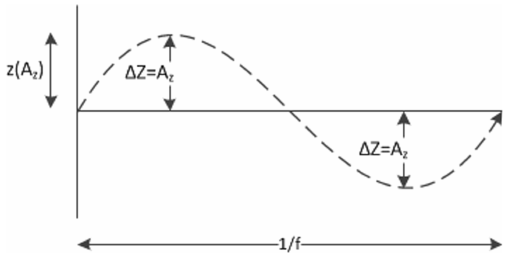
Fig. 7. Position ( z) of mean interface as a function of time ( t) for